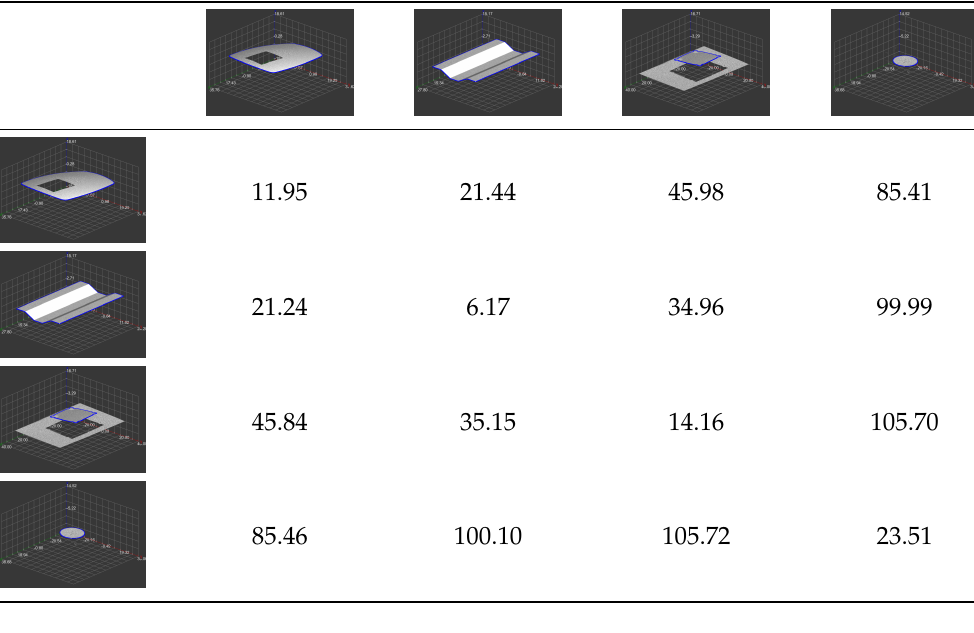
Table 2. The average result precision and time consumption of the whole processing pipeline for selected types of